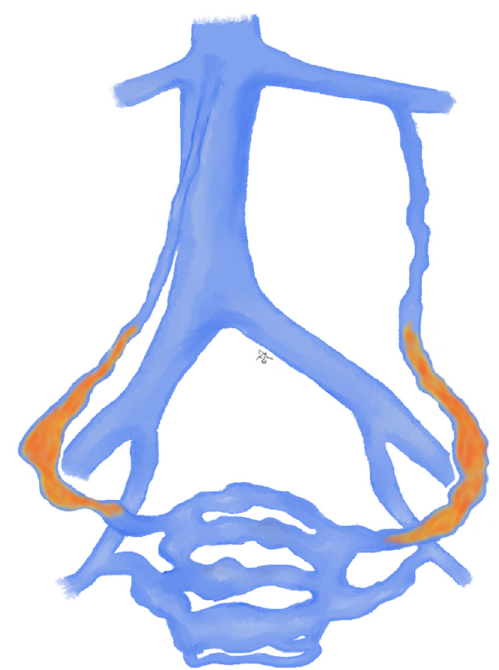
Figure 6. Drawing shows left and right ovarian veins embolization with glue: embolization should start from the distal portion of the ovarian vein at the level of the upper half of the sacroiliac joint, to include possible collateral branches.